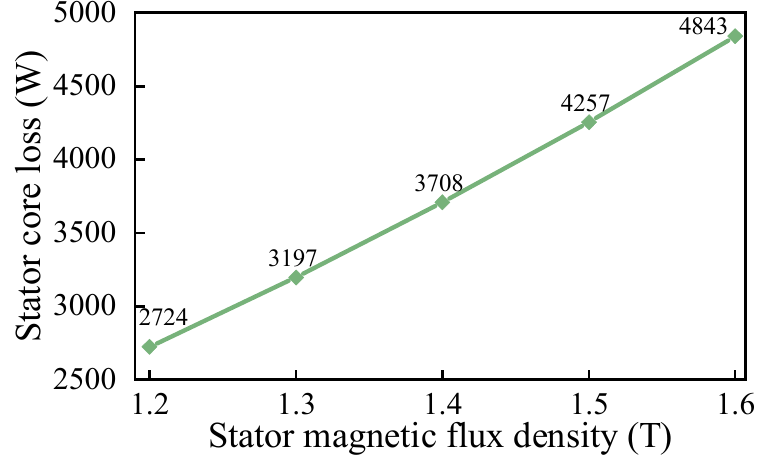
Figure 8. Stator core loss under different stator magnetic flux density.